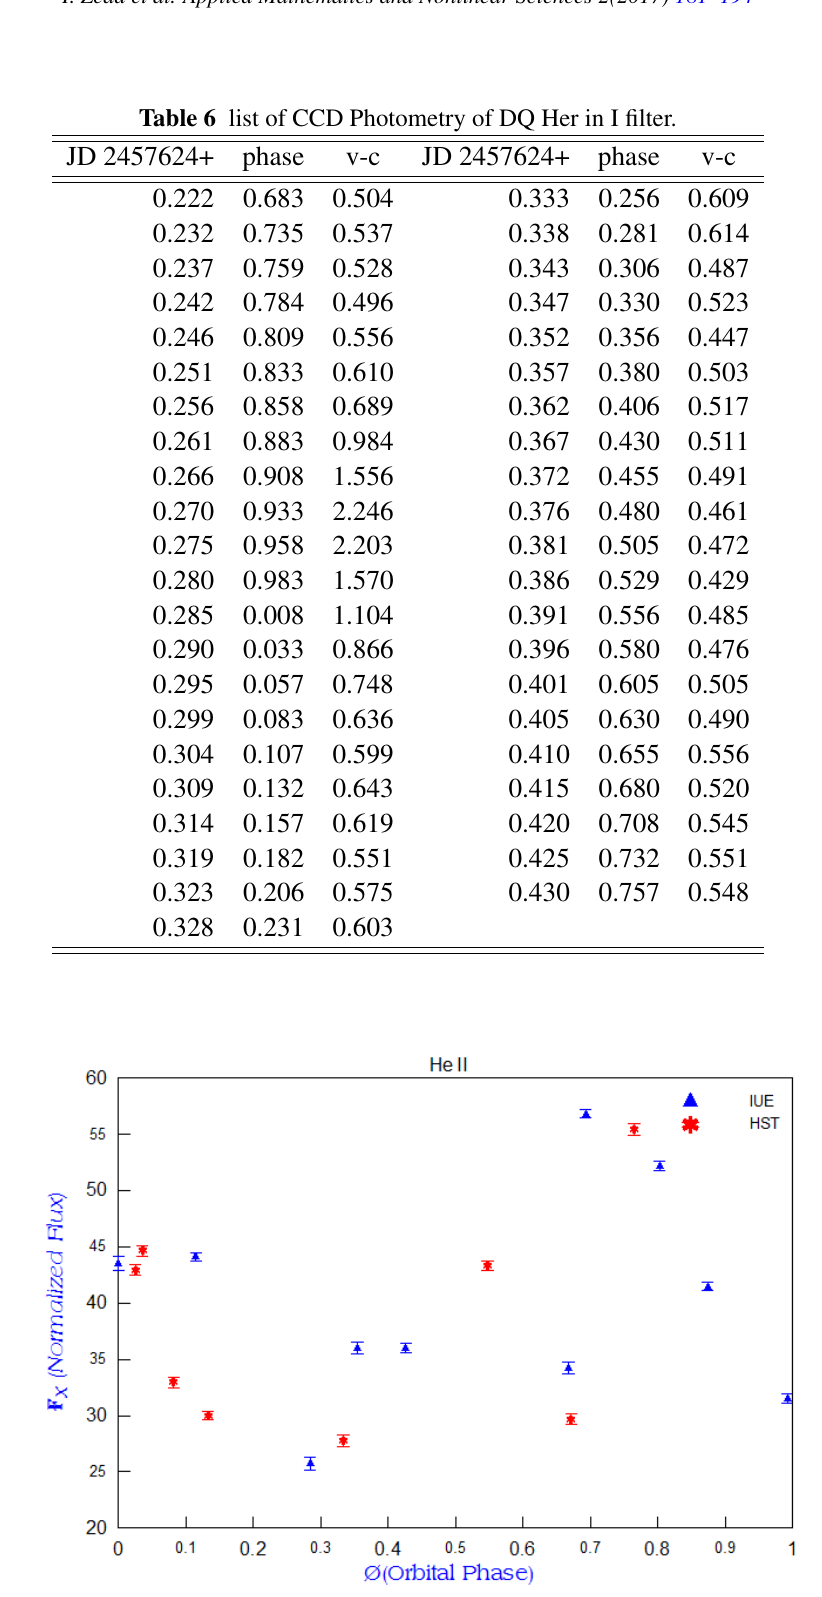
Fig. 9 Variation of the He II line flux with phase of DQ Her The 1 σ error bars are shown on each data